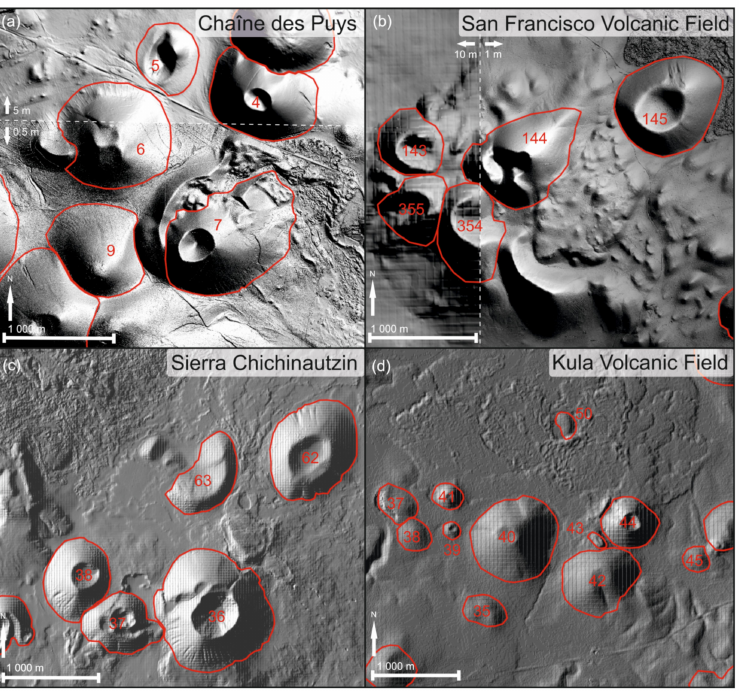
Figure 3. Examples of the DTMs of the four areas; examined cones are outlined in red. The bor- ders of DTMs with different resolutions available in each area are marked with a white-hatched line ( a ) Chaîne des Puys, ( b ) San Francisco Volcanic Field, ( c ) Sierra Chichinautzin and ( d ) Kula Volcanic